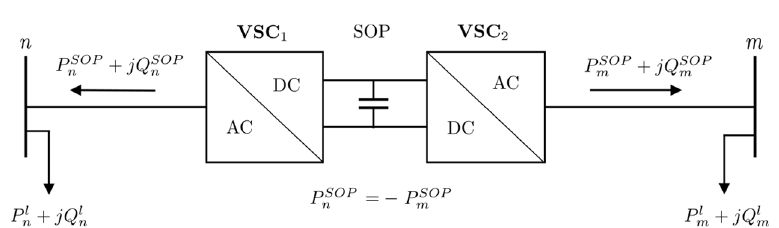
Figure 1. SOP model placed at the sectionalizing switch.